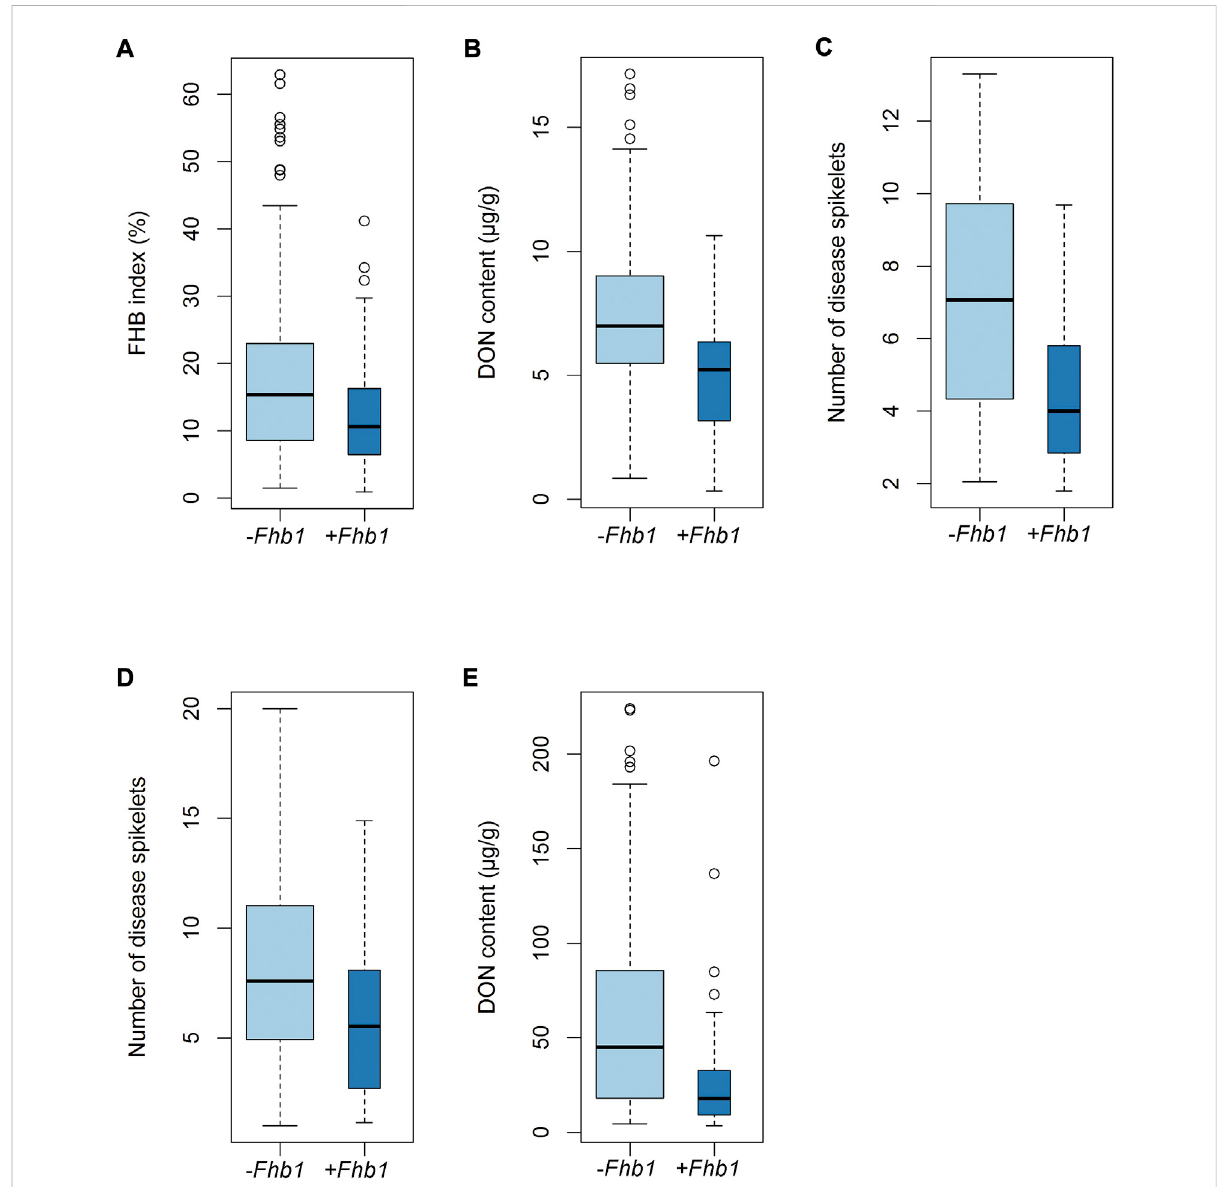
FIGURE 3 Differences in FHB index (A), number of diseased spikelets (C and D) and DON content (B and E) between Fhb1 and non- Fhb1